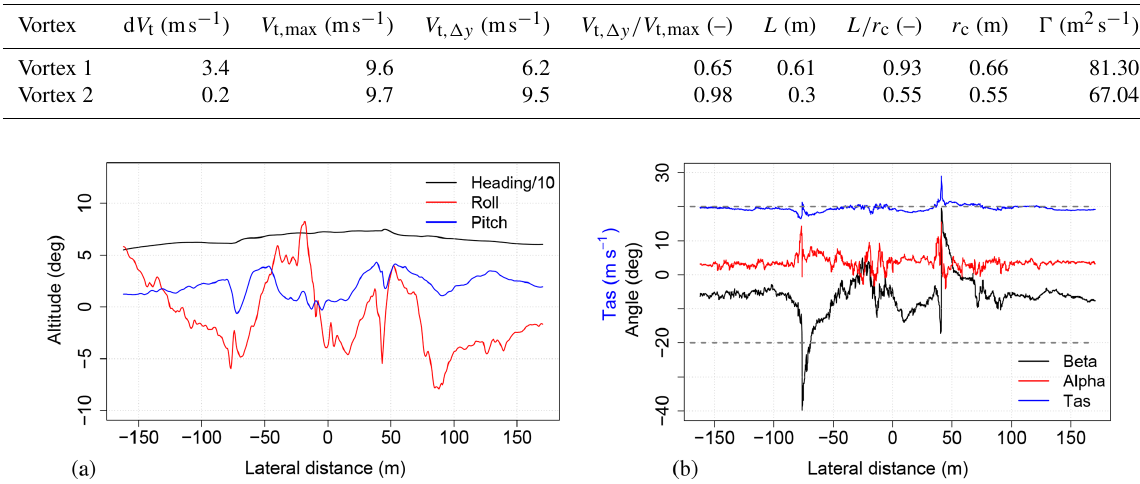
Table 2. Determined parameters from vortex measurements.